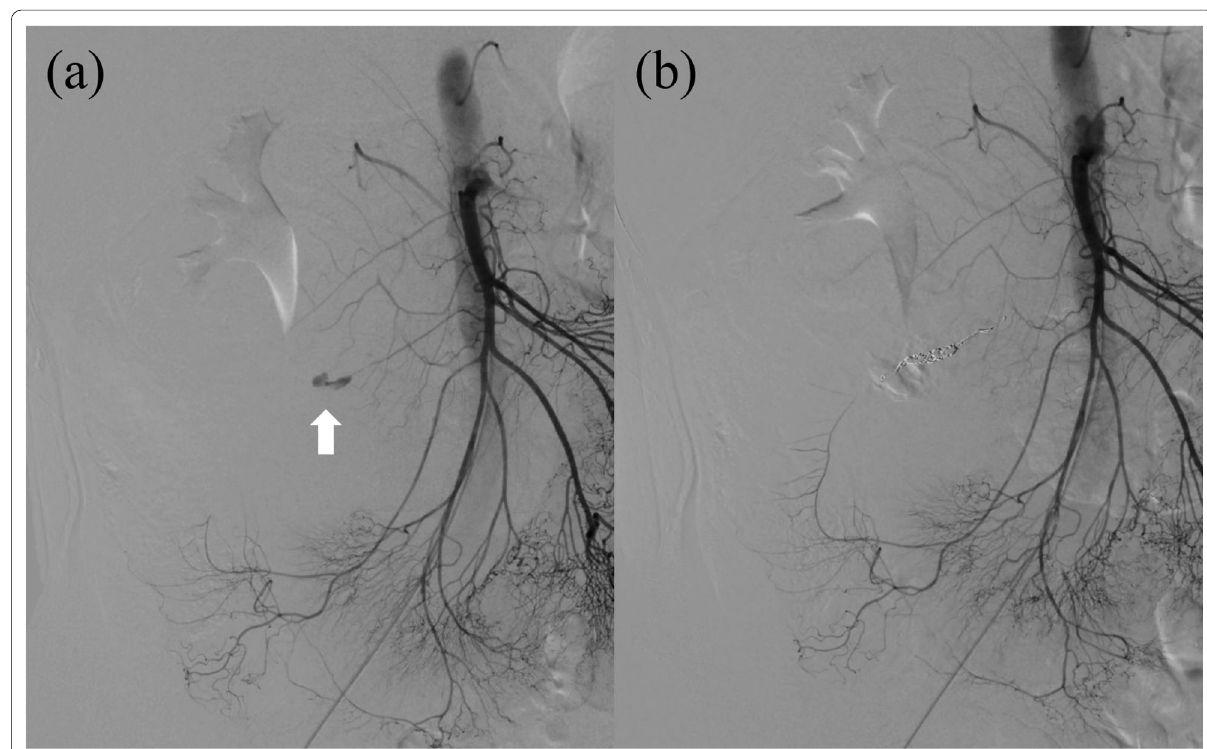
Fig. 2 The angiography image shows the aneurysm of the right colic artery (arrow) ( a ) and coil embolization to the aneurysm ( b